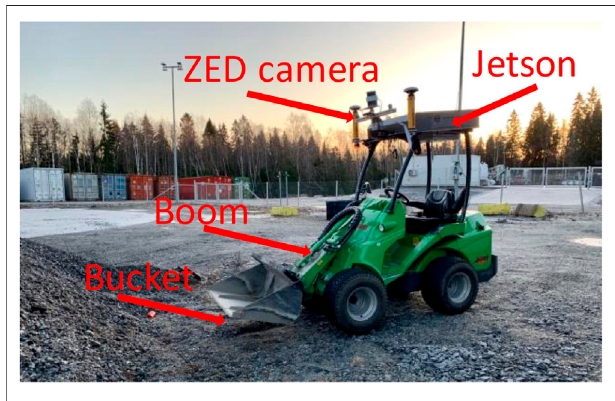
FIGURE 4 | Robotic set-up at test